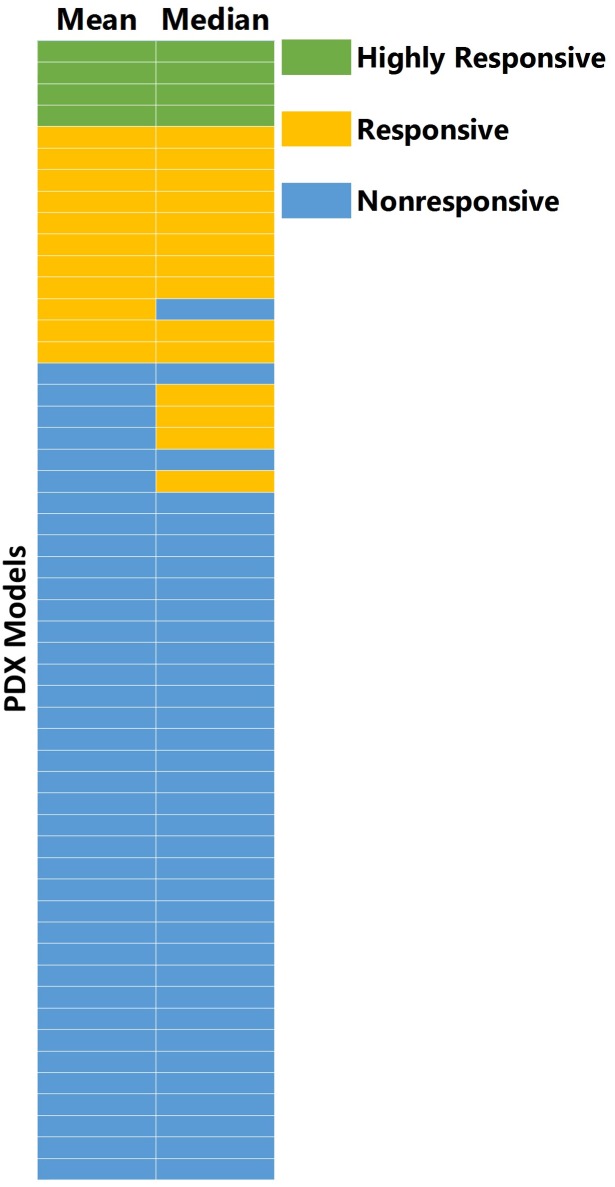
Comparison of treatment response values from median and mean tumor volumes.A total of 10% (five models of 50) of PDX models have a change in classification when calculating response with mean as opposed to median. The five models (TM00302, TM00214, TM00222, TM00185, TM01563) were all lung models, with four of the five models from primary tumors (not from tumors of metastatic or relapsed disease). Of the five models that differ in classification, mean is more sensitive for one model, TM00185, while median is more sensitive for four.